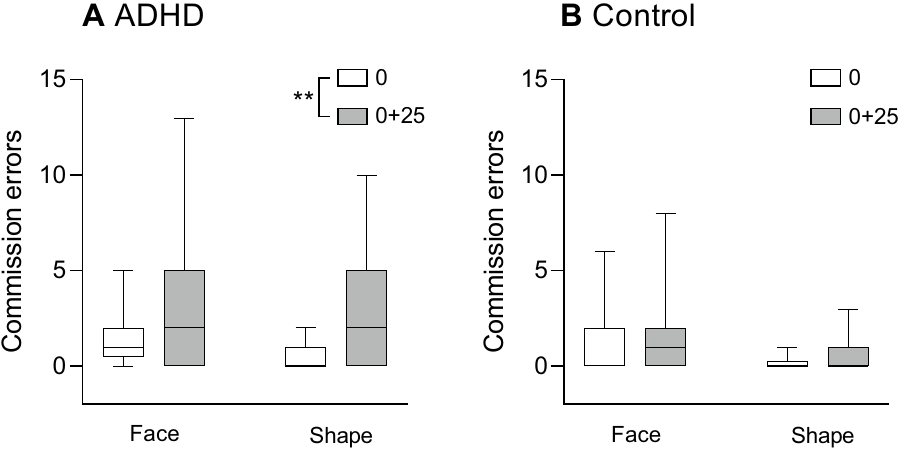
Figure 4. Rates of commission errors on trials with non-target faces or non-target shapes for the ADHD group (A) and the control group (B). Differences between the rates of omission errors before (time 0) and after sleep deprivation (time 0 + 25) were examined across target type for each group using the Wilcoxon signed-rank test. **p <